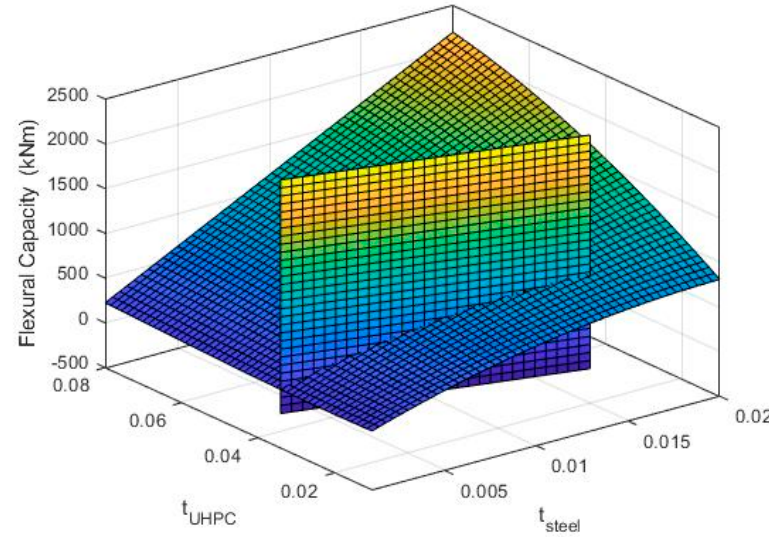
Figure 12. Flexural capacity as a function of steel and UHPC thicknesses.